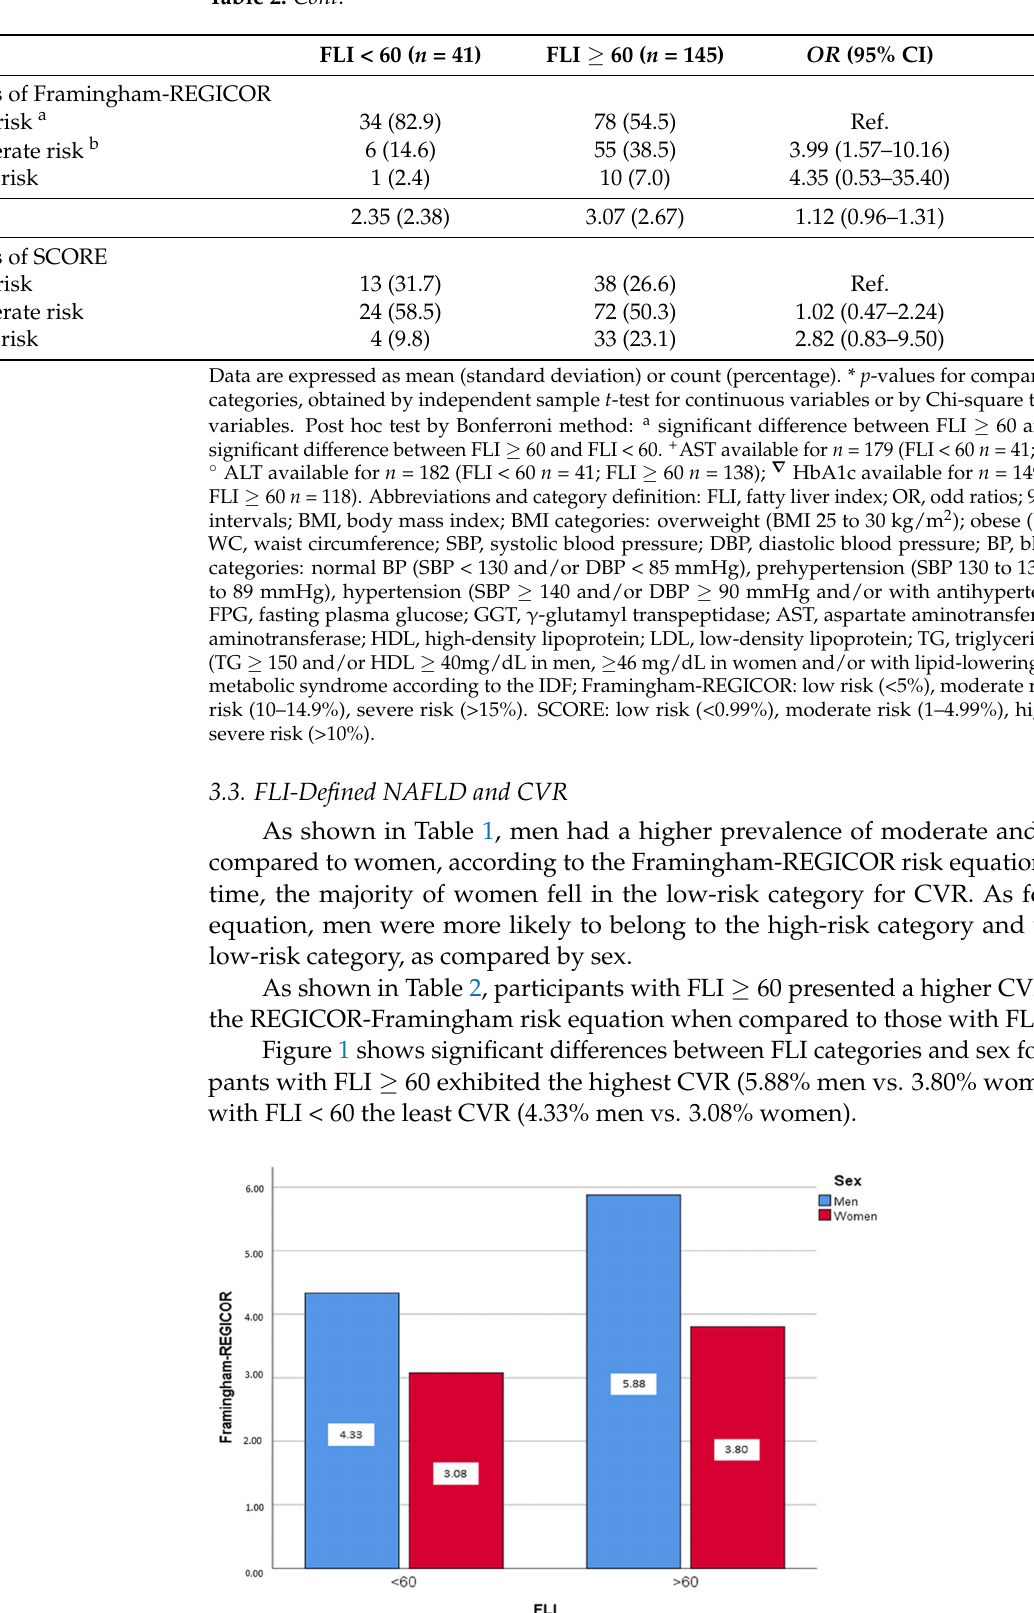
Figure 1. Mean Framingham-REGICOR values according to FLI categories (FLI < 60 and FLI ≥ 60) by sex. χ 2 test, p < 0.05.